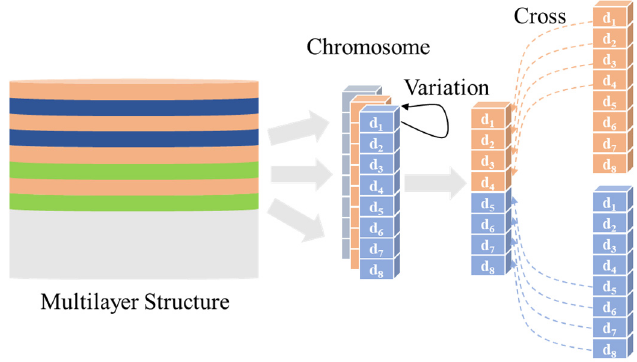
Figure 4. Genetic algorithm process diagram.